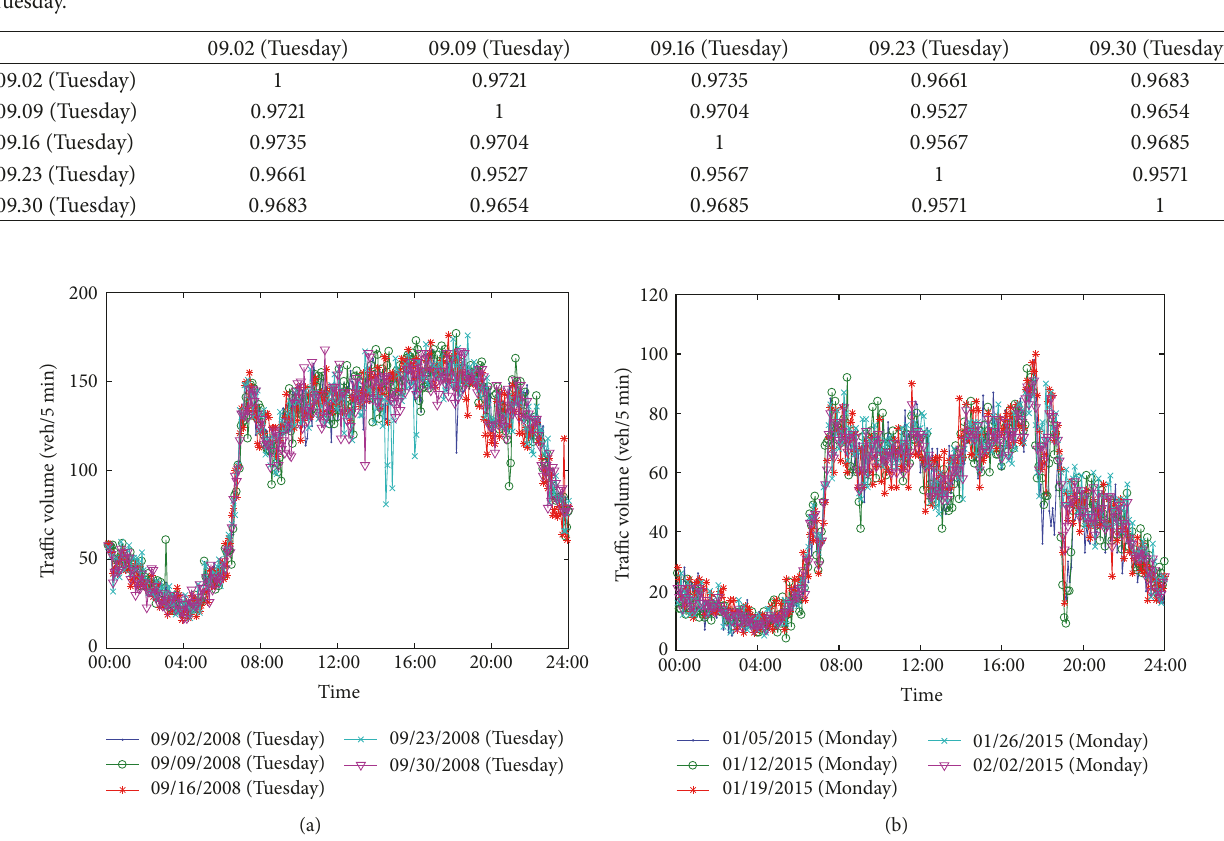
Figure 6: An example for illustrating the “day pattern”: (a) urban expressway and (b) urban arterial road.